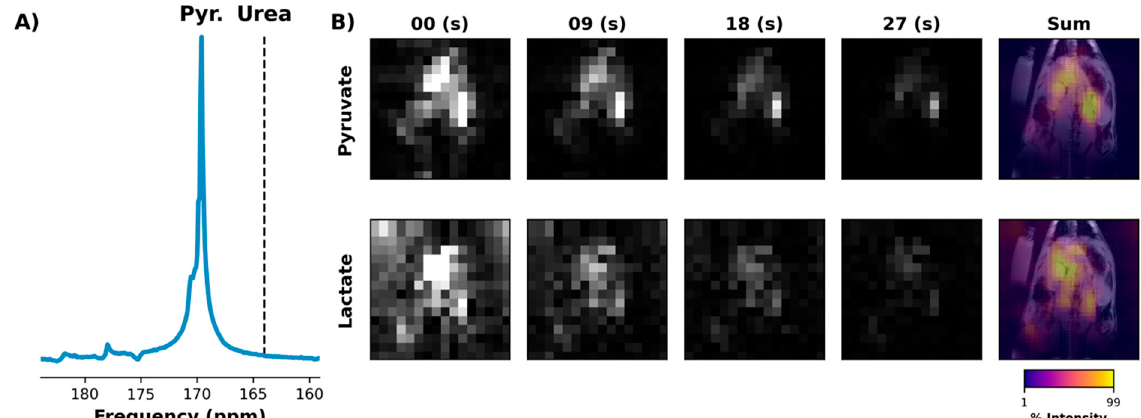
Figure 7. 13 C frequency spectrum acquired from 4 cm-thick slab that included the rat liver and kidneys but excluded the heart and lungs ( A ). The spectrum was obtained just after the injection of [1- 13 C]pyruvate using a small flip angle. An automated script was used to move the scanner center frequency from the urea resonance (dashed line) to that of pyruvate. The script then triggered the start of an EPI acquisition that used SSRF frequency offsets computed relative to the pyruvate resonance ( B ). Both pyruvate (1st row) and lactate images (2nd row) were of similar quality to prior experiments in which the frequency offsets were computed using a separate HP injection (Figures 4 and 5).